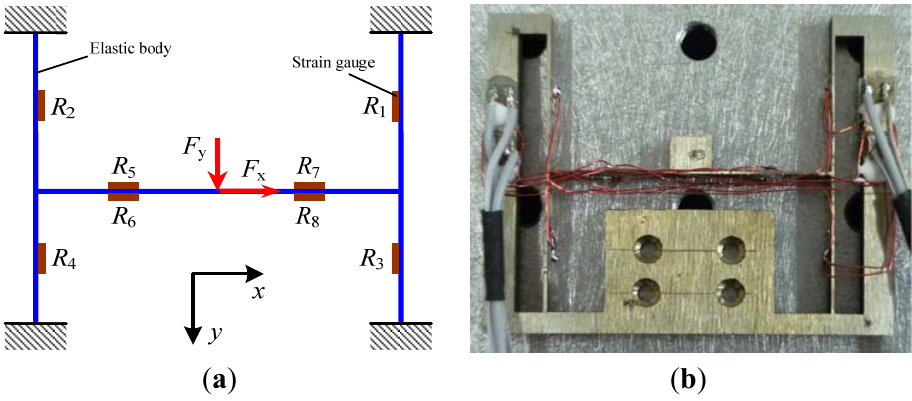
Figure 1. The schematic diagram ( a ) and the corresponding prototype ( b ) of the sensor.